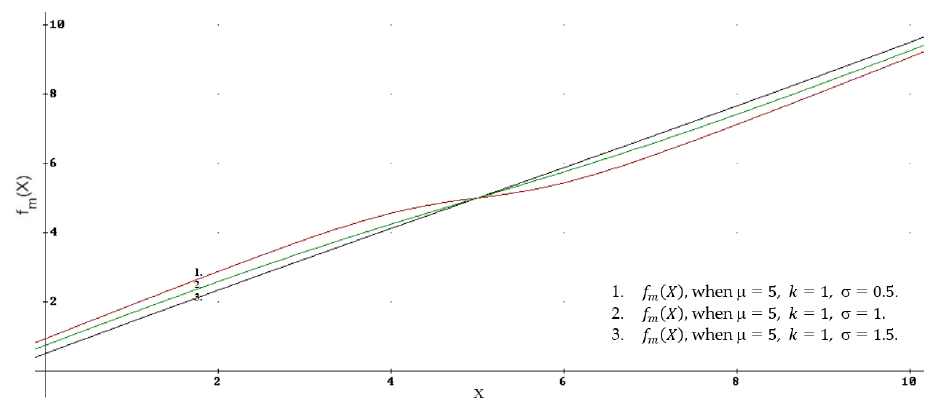
Figure 5. Dependence of the function 𝑓 𝑚 (𝑋) in case 5 on different σ , when μ = 5, 𝑘 = 1